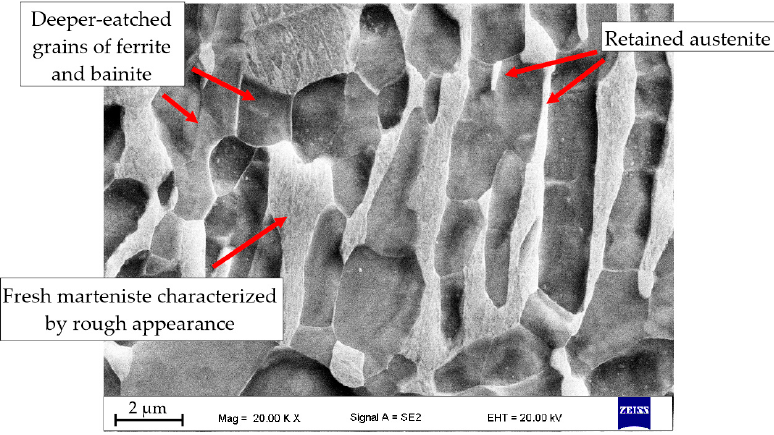
Figure 9. Characterization of the 750D sample morphology.